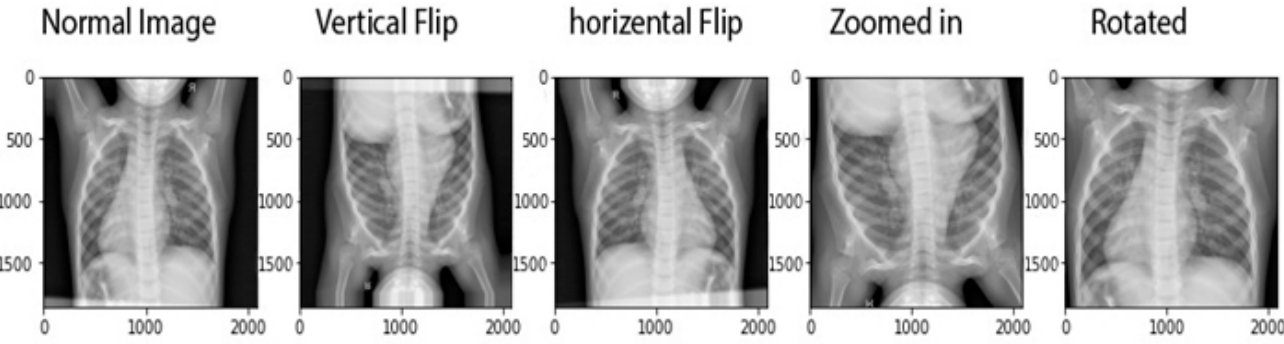
Figure 5. Samples of data augmentation techniques applied on a single image.